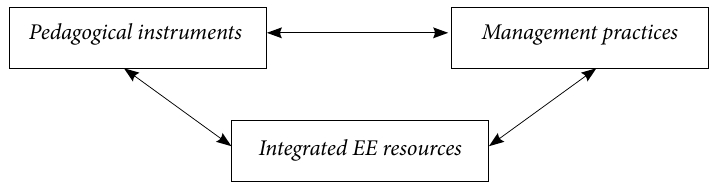
Fig. 2. Pedagogical instruments and management practices integration in the